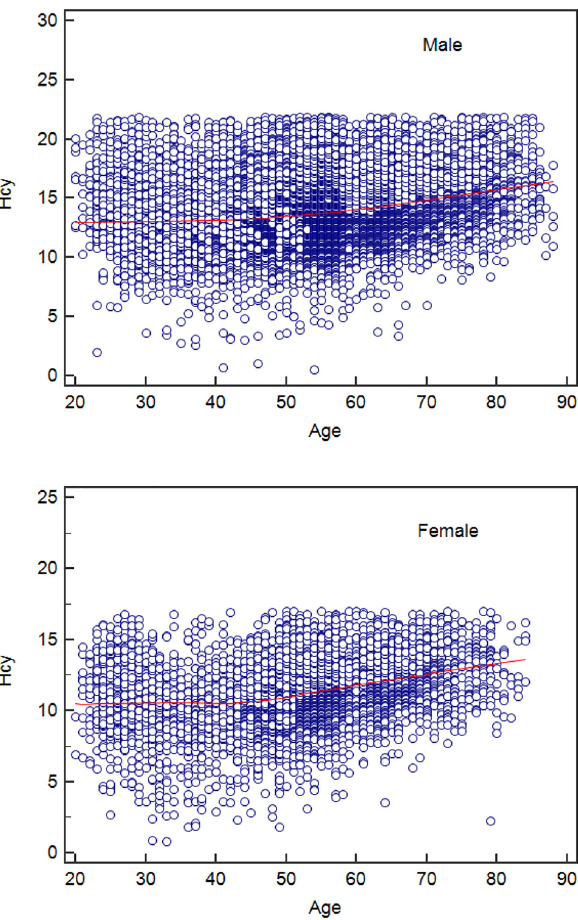
Figure 3: Scatter diagram showing variation of the serum level of homocysteine (Hcy) with age. The unit of Hcy is µmol/L.